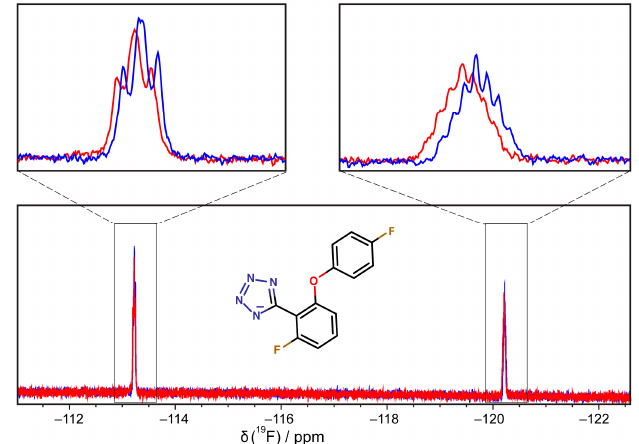
Figure 5. 1D 19 F-NMR spectra of compound 5 at 1 mM in the presence (red trace) and absence (blue trace) of 50 μ M DnaGC.